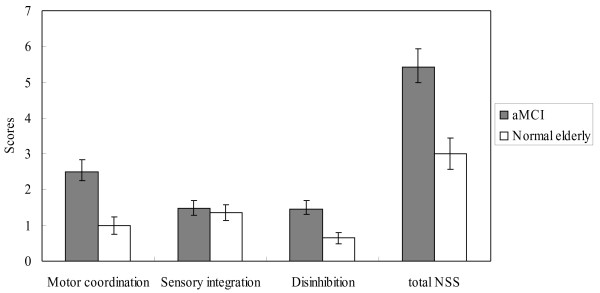
Comparisons of neurological soft signs in persons with aMCI and normal elderly. Error bars represent 95% confidence intervals.